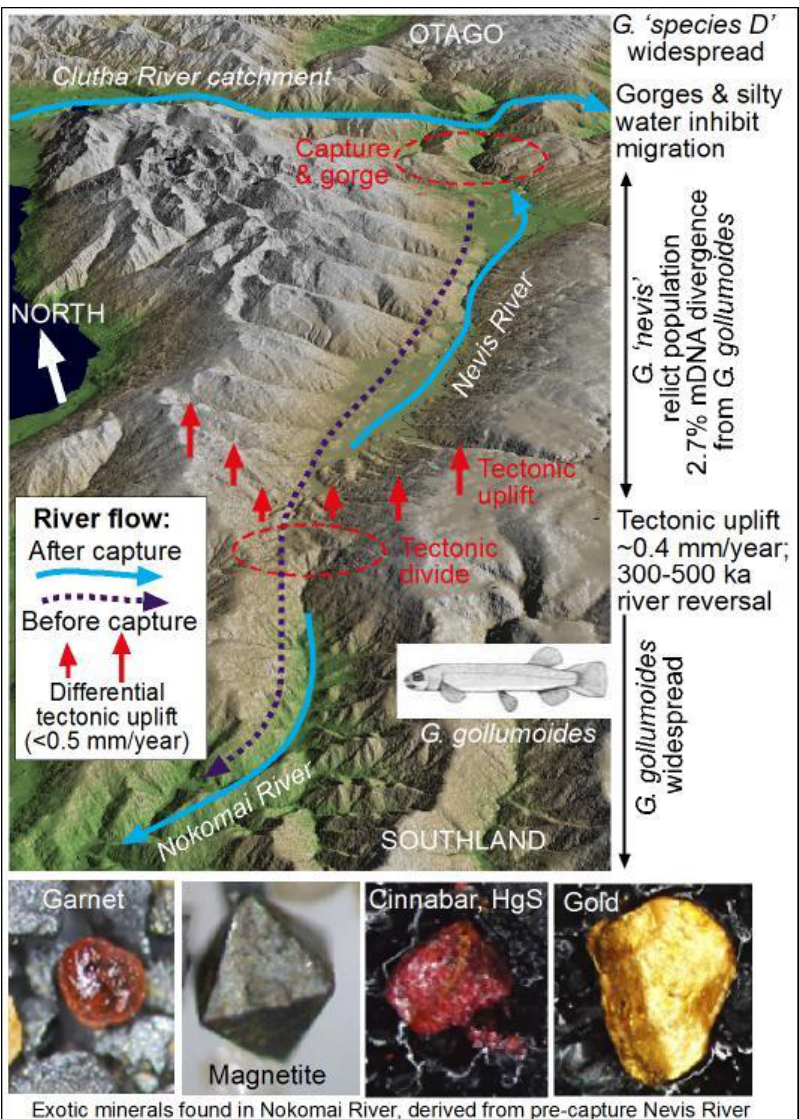
Figure 3. Mid-late Pleistocene reversal of the Nevis River, Central Otago, led to the isolation and divergence of the distinctive Nevis galaxiid ( G. ‘nevis’), sister to the ‘Southland’ species G. gollumoides , thus generating a persisting biogeographic anomaly within the Clutha River system (Figures 1 and 2). Exotic minerals present in the Nokomai River highlight its former connection with the Clutha system.